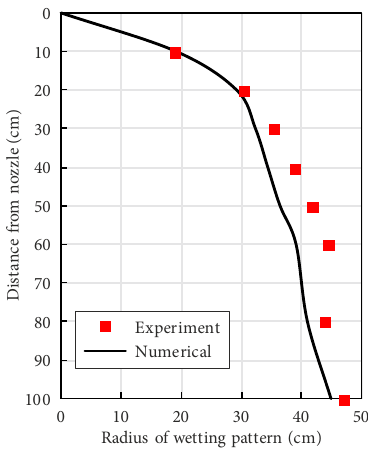
Figure 7. Validation of nozzle flow from numerical model